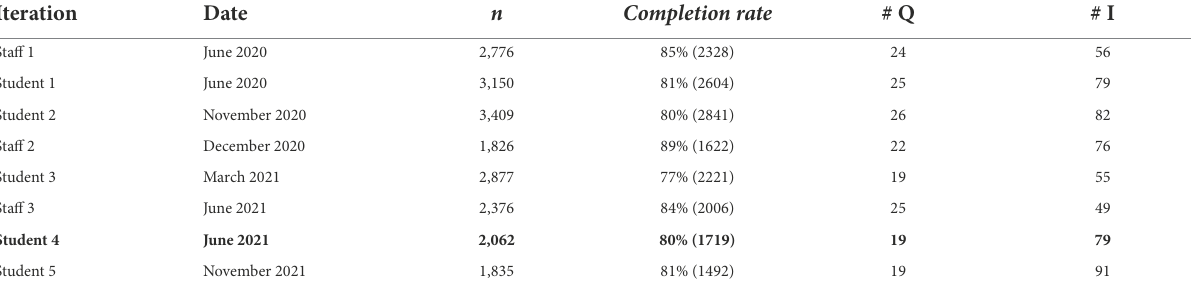
TABLE 5 An overview of the different iterations of wellbeing assessment conducted at Delft University of Technology.